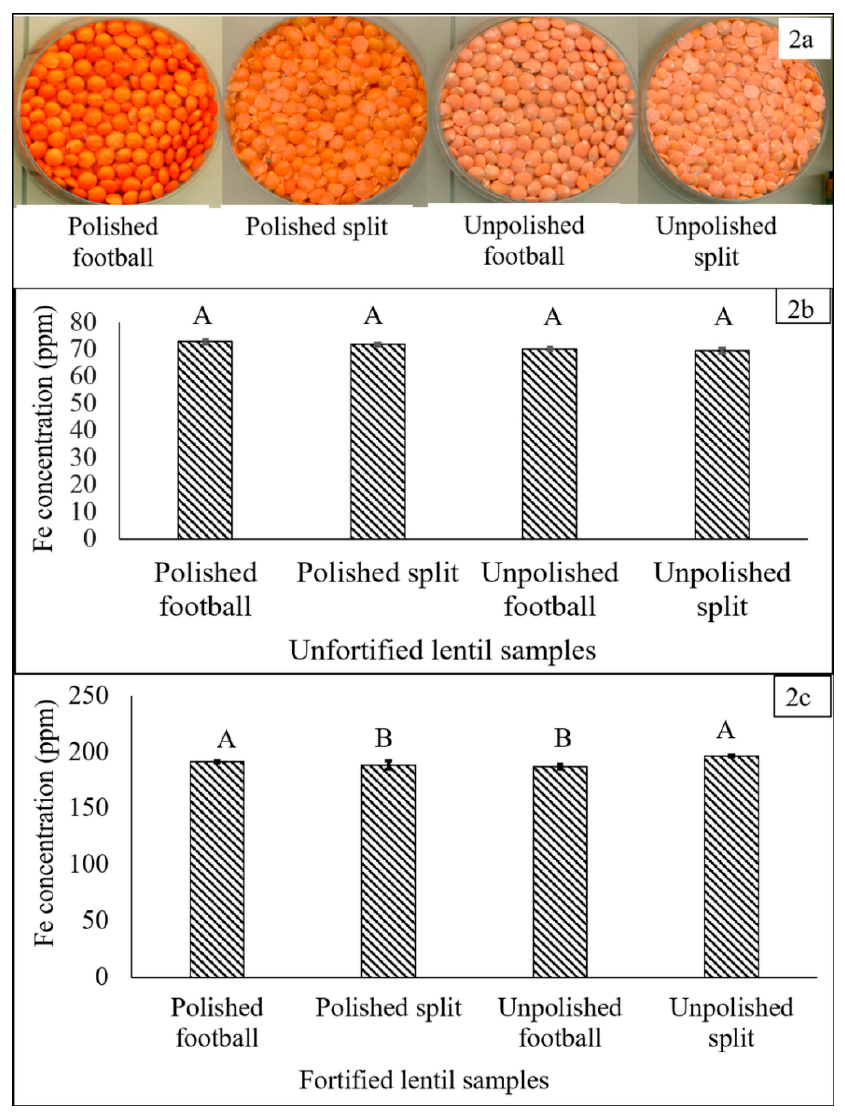
Figure 2. ( a ) Four dehulled, red lentil product types; ( b ) Fe concentration (ppm) in four dehulled, unfortified, red lentil product types; and ( c ) Fe concentration (ppm) in red lentil product types fortified with FeSO 4 · 7H 2 O solution (400 ppm Fe). Different letters within each figure represent significant differences ( p < 0.05).